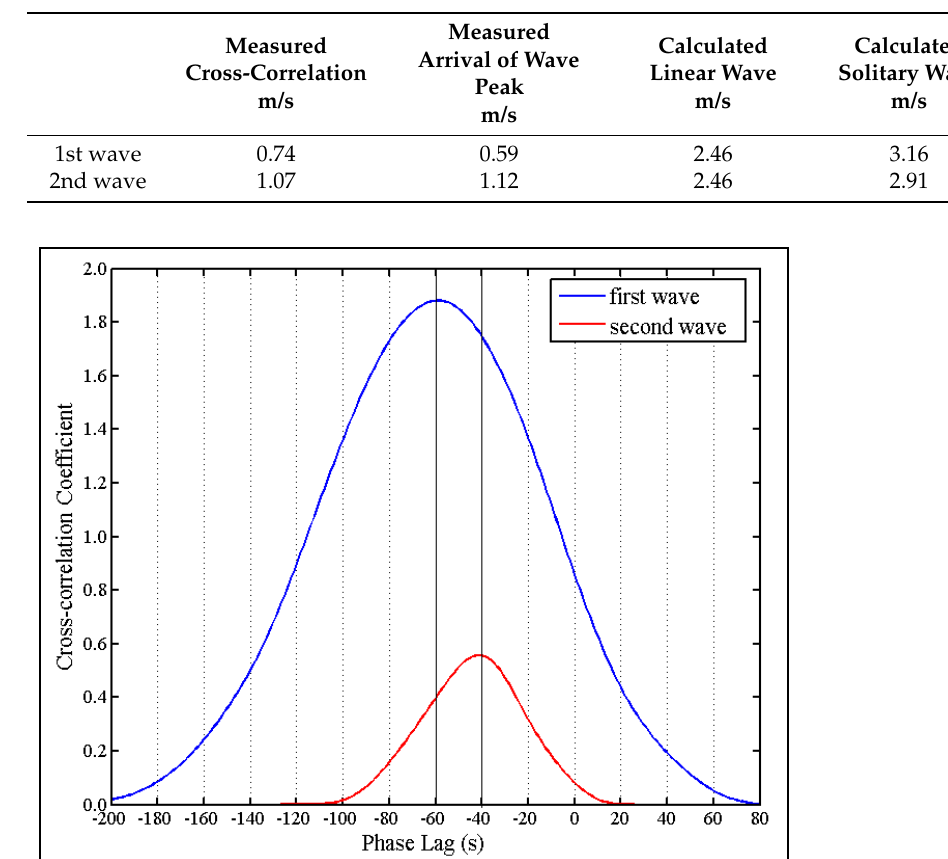
Table 1. Comparison among measured and calculated wave speeds.